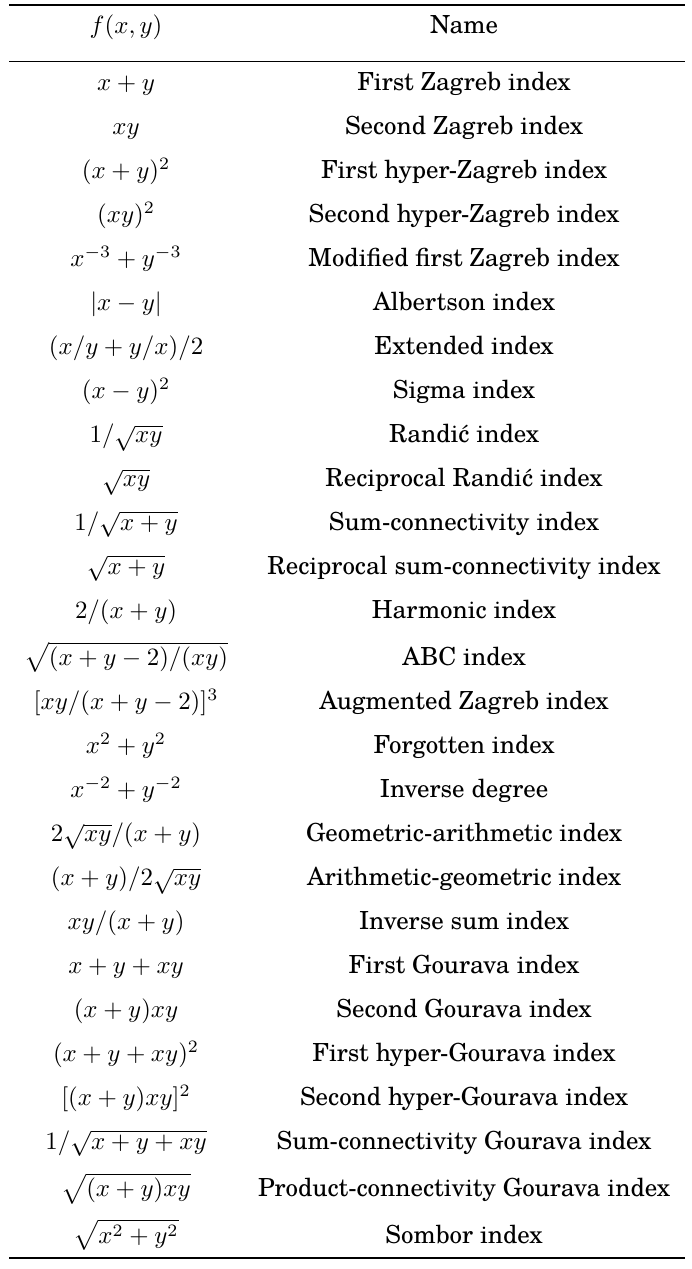
Table 1: Some edge-weight functions and related chemical